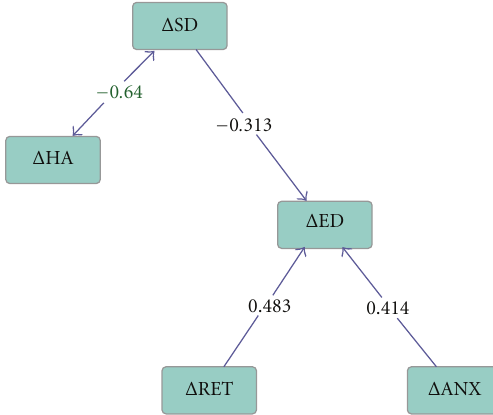
Figure 2: Pathways assessed by Structural Equation Modelling of relations between change scores over two years for the personality dimensions of Harm-Avoidance ( Δ HA) and Self-Directedness ( Δ SD), and the dimensions of psychopathology of Emotional Dysregulation ( Δ ED), Retardation ( Δ RET) and Anxiety ( Δ ANX) in 58 patients with major depression. The numbers represent correlation coe ffi cients, except for the ambiguous relation between Δ SD and Δ HA, which is expressed in terms of the covariance coe ffi